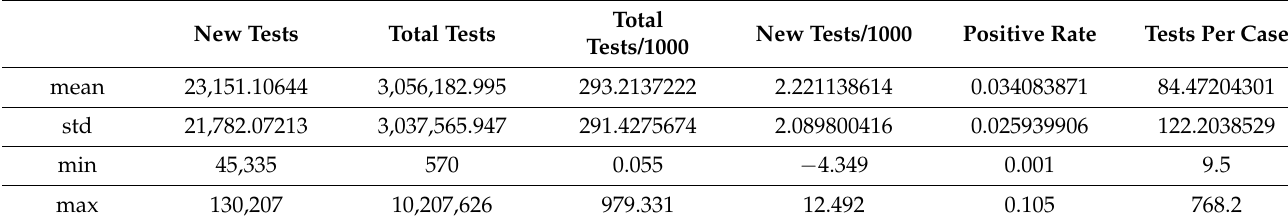
Table 2. Pandemic Statistic Analysis_2.